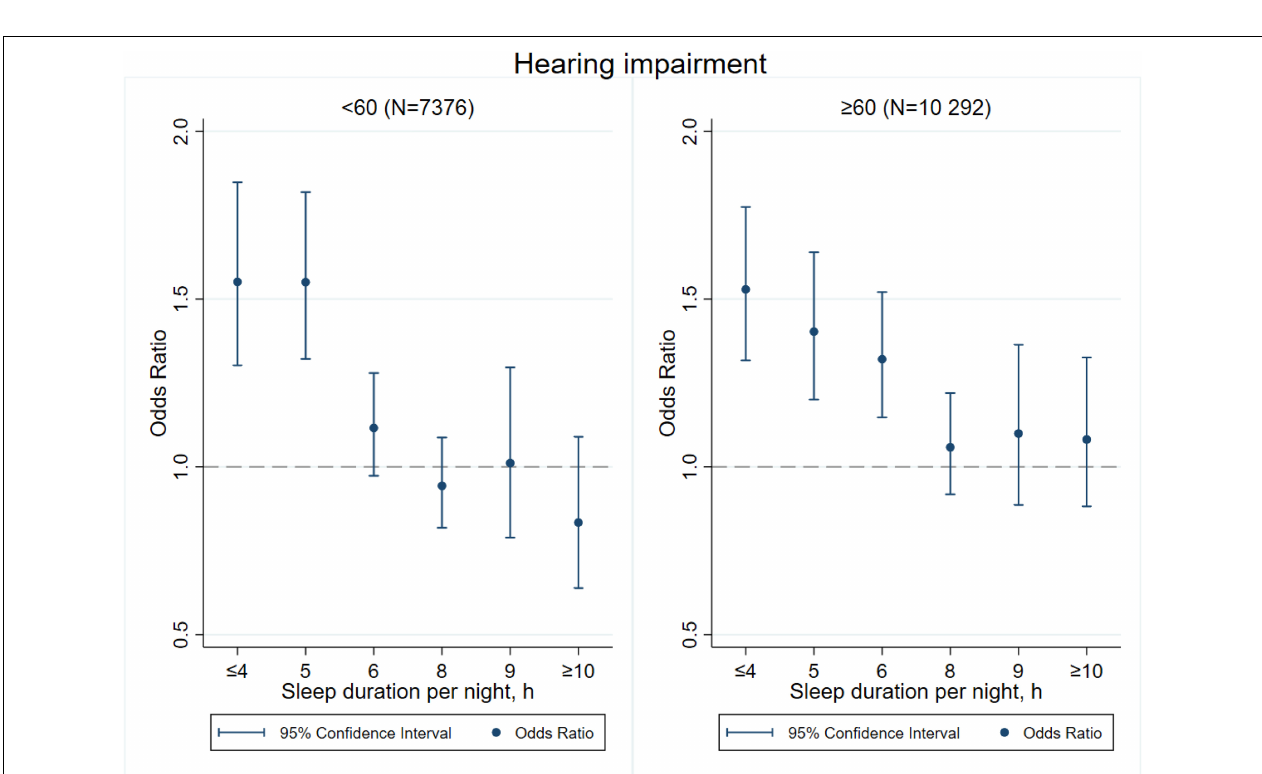
FIGURE 7 | Age-specific effect of sleep duration on hearing impairment.